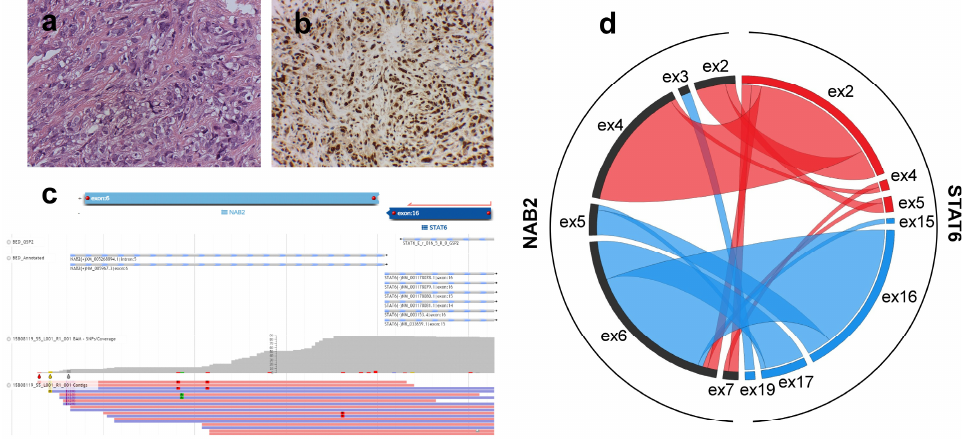
Figure 1. Pathological and molecular characterization of solitary fibrous tumors (SFTs). ( a ) Hema- toxylin and eosin staining and ( b ) strong nuclear expression of STAT6 of a meningeal SFT. Magni- fication 40 × . ( c ) Top panel: schematic representation of NAB2 exon 6 and STAT6 exon 16 fusion variant and gene specific primer (in red) that covered STAT6 gene. Middle panel: Sequence align- ment between reference and sample sequences. Bottom panel: Mapping of individual reads and coverage supporting the fusion variant between NAB2 exon6 (NM_005967.3) and STAT6 exon16 (NM_001178078.1). ( d ) Circos plot showing identified NAB2-STAT6 gene fusion variants from all the STF cases. Fusion variants classified into STAT6-FULL group are represented by red segments and ribbons, whereas fusion variants classified into STAT6-TAD group are represented in blue. Black segments represent NAB2